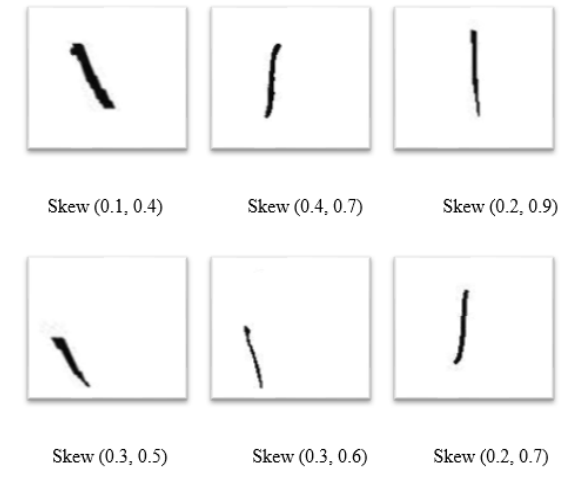
Fig. 2. Dataset augmentation